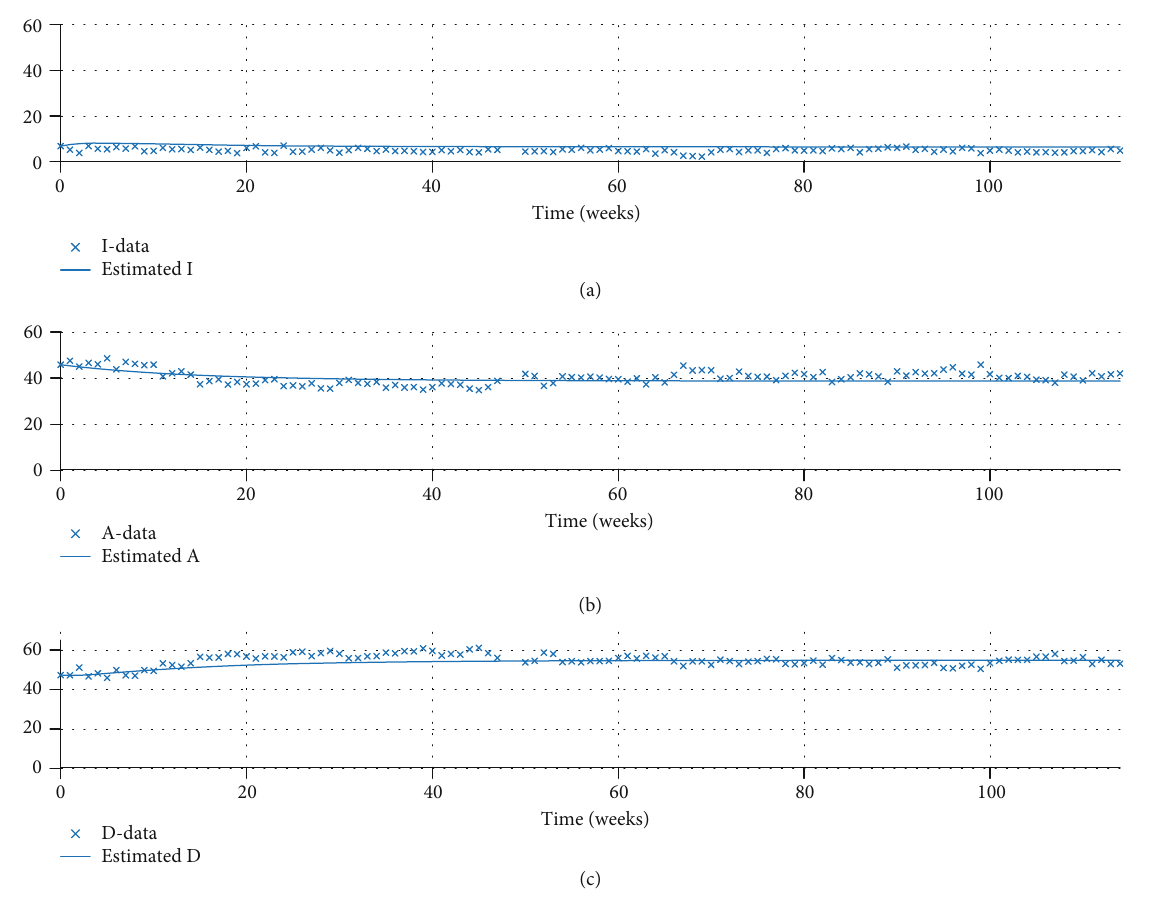
Figure 6: The Agree-Disagree model fi ts for the second poll data. (a) The solid line depicts the model output for I , while the small crosses show the indi ff erent data. (b) The solid line depicts the model output for A , while the small crosses show the Agree data. (c) The solid line depicts the model output for D , while the small crosses show the Disagree